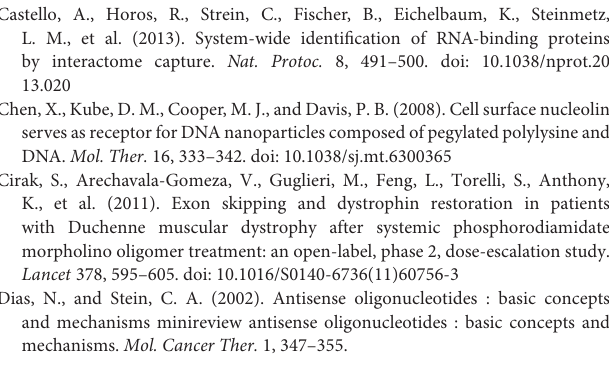
FIGURE 4 | followed by an analysis using a fluorescent microscope. Bar = 15 µ m. UT, untreated cells. (B) Relative fluorescent units of FITC-conjugated 2OMePS 4h post-treatment in C2C12 myoblasts pretreated with siRNA against Ncl or Tcp1 . (C) Effect of knockdown of Ncl or Tcp1 on splicing efficiency in HeLa_705 with 2OMe SSO. (D) Ncl protein overexpression and impact on SSO activity upon lipofection. HeLa_705 cells are transfected with Ncl-encoding plasmid DNA (pDNA) for 24h. Then, these and control cells are further treated with 2’-OMePS for 24h, after which splice-switching activity was measured. O/E Ncl: the activity of lipofected SSOs in Ncl overexpressing cells. P < 0.05 was defined as statistically significant. * p < 0.05; ** p ≤ 0.01, *** p ≤ 0.001. (E) BLItz label-free protein assays. The recombinant Ncl (RPC242Mu01, Cloud-Clone Corp, Katy, TX, USA), a recombinant protein of amino acids Tyr353–Ser568 of Ncl and an N-terminal His-Tag (NCL-His), was used for these assays. KD, the equilibrium dissociation constant between an antibody and its